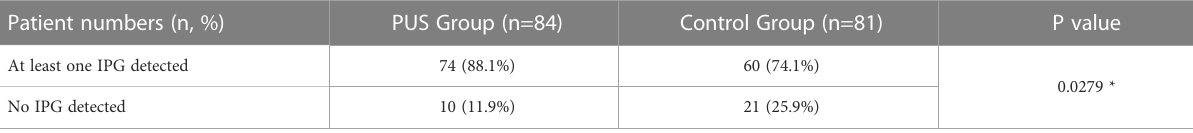
TABLE 3 Comparisons of intra-operative localization of IPG in PUS Group and Control Group. Patient numbers (n,